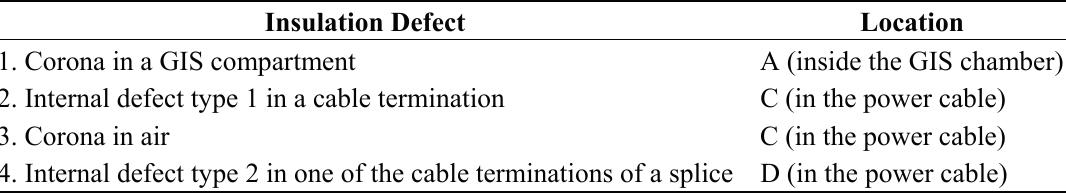
Table 1. Type of defect and